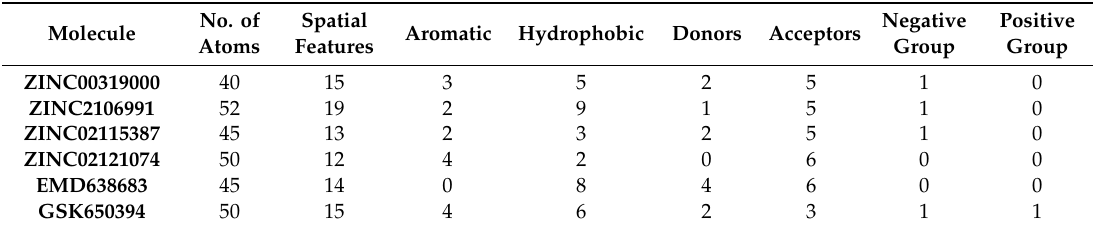
Table 6. Spatial pharmacophore features of the selected compounds along with known SGK1 inhibitors (EMD638683 and